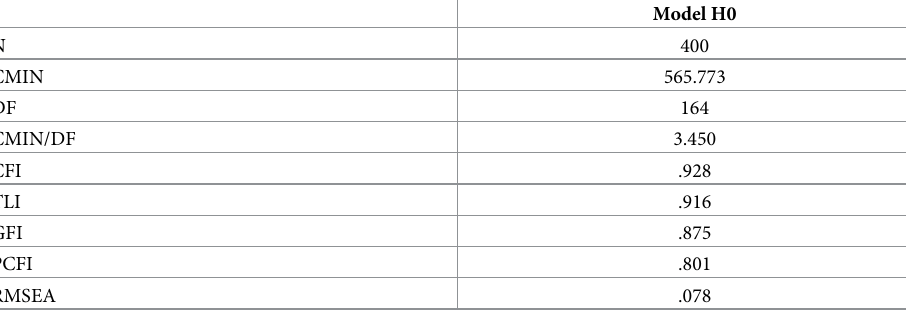
Table 6. Model fit indices for the data collected using